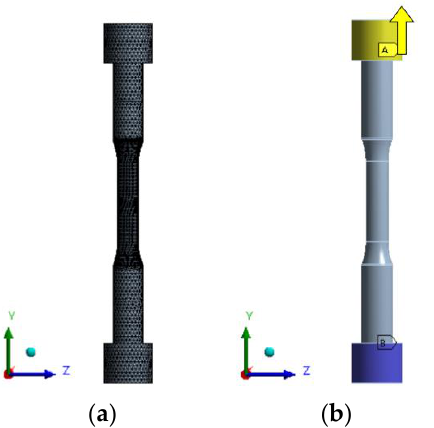
Figure 19. Finite element modeling and boundary conditions of tensile specimens: ( a ) Finite element modeling; ( b ) Boundary conditions.